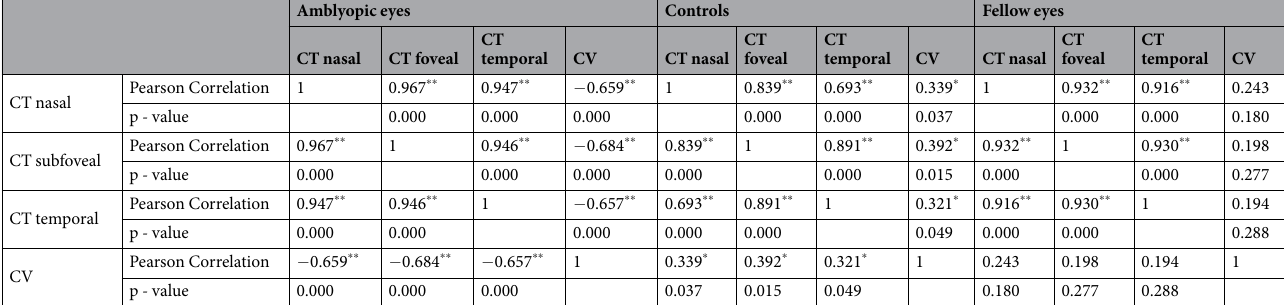
Table 4. Correlation between choroidal thickness and choroidal vascularity in each group. CT: choroidal thickness; CV: choroidal vascularity. ** Correlation is significant at the 0.01 level (2-tailed). * Correlation is significant at the 0.05 level (2-tailed).